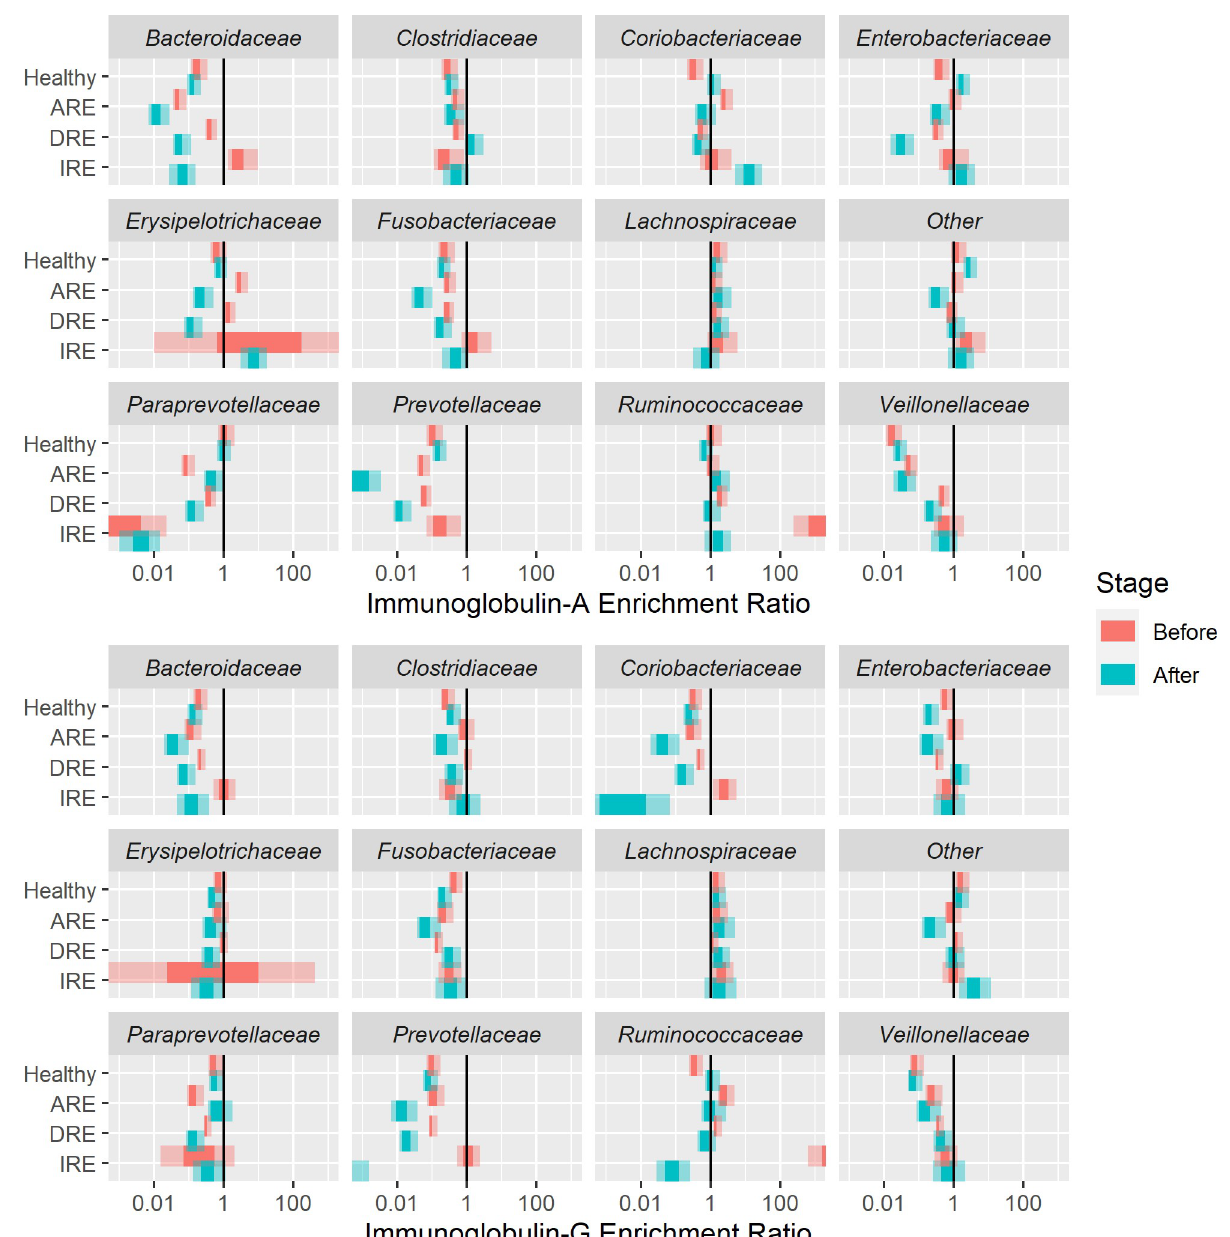
Fig 6. Immunoglobulin enrichment ratio at family level. (A) Immunoglobulin A. (B) Immunoglobulin G. DRE: Diet-responsive enteropathy. ARE: Antibiotic-responsive enteropathy. IRE: Immunosuppressant-responsive enteropathy. ‘Before’ corresponds to V1 in healthy dogs and active disease in CE dogs. ‘After’ corresponds to V2 in healthy dogs and remission in CE dogs. Top eleven of the most represented families. Other includes the remaining families. The central credible interval corresponds to 50% and the outer interval to